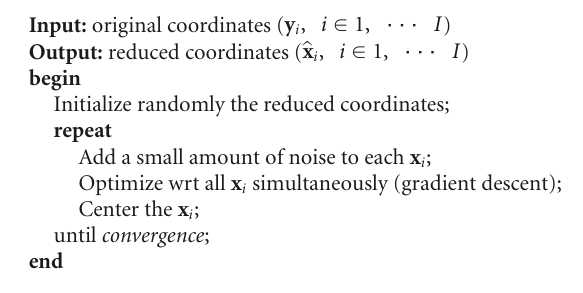
Algorithm 1: Standard compression